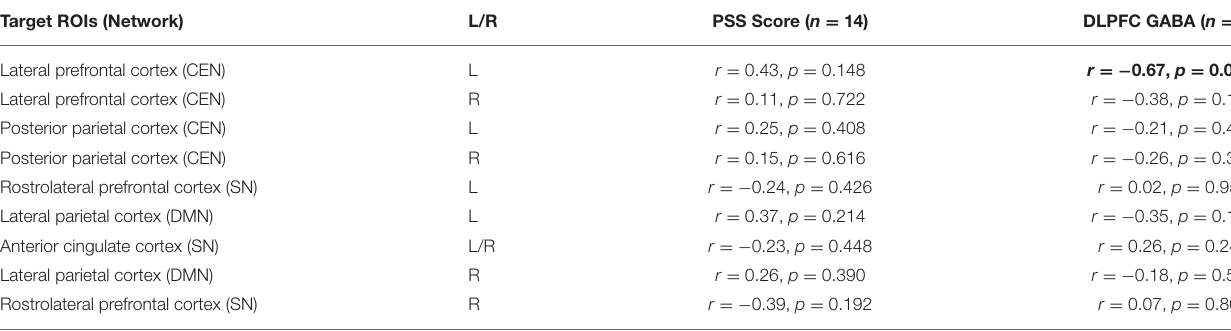
TABLE 2 | Correlations of PSS scores and DLPFC GABA with significant RSFC from the DLPFC voxel seeds. Target ROIs